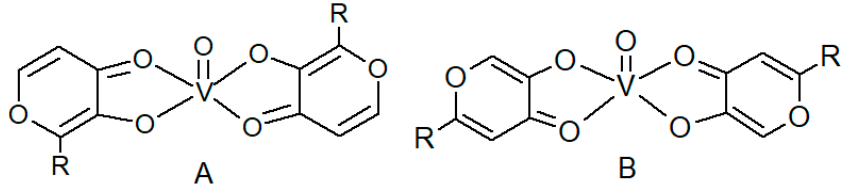
Figure 1. Structures of hydroxy-pyronato-oxovanadium(IV) coordination compounds. ( A ) Structure of bis(2-alkyl-3-hydroxy-4-pyronato)oxovanadium(IV); ( B ) structure of bis(2-alkyl-5-hydroxy-4-pyronato)oxovanadium(IV).